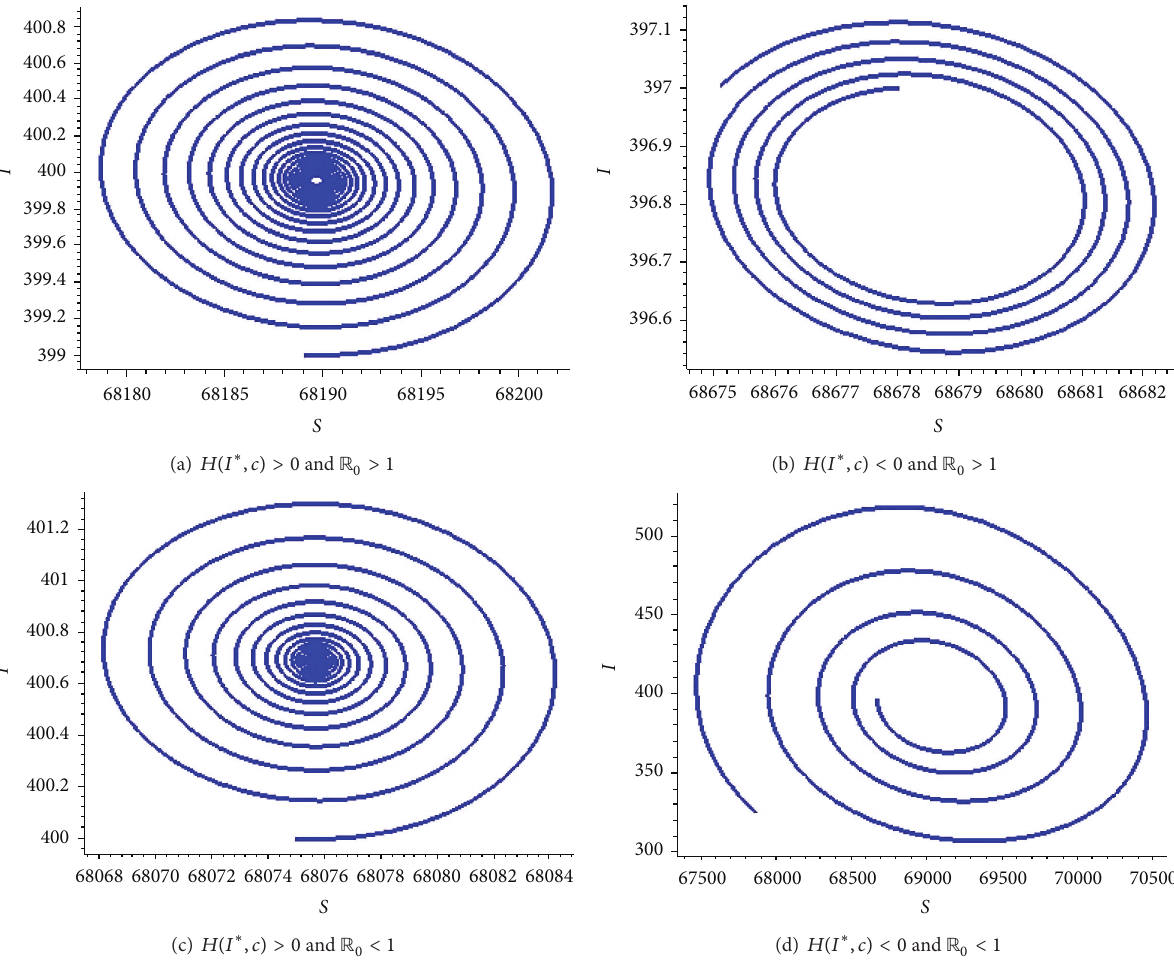
Figure 3: The phase portraits of the model where the directions of trajectories are